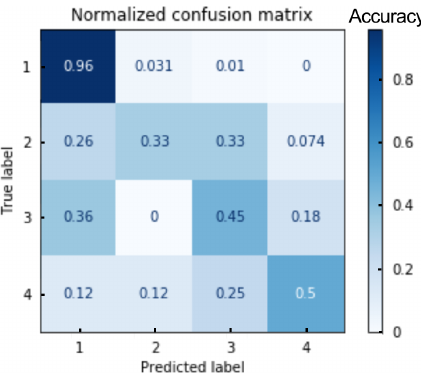
Fig. 8 Normalized confusion matrix of a four-layer